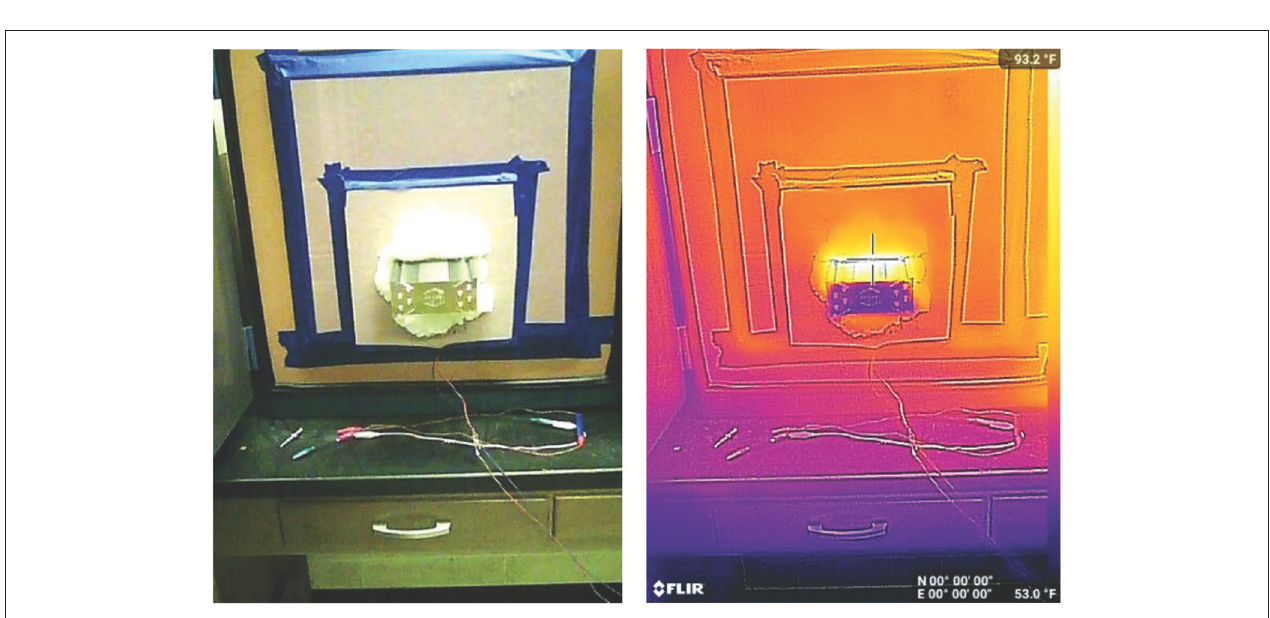
FIGURE 7 | Assembly testing in thermal chamber with thermal